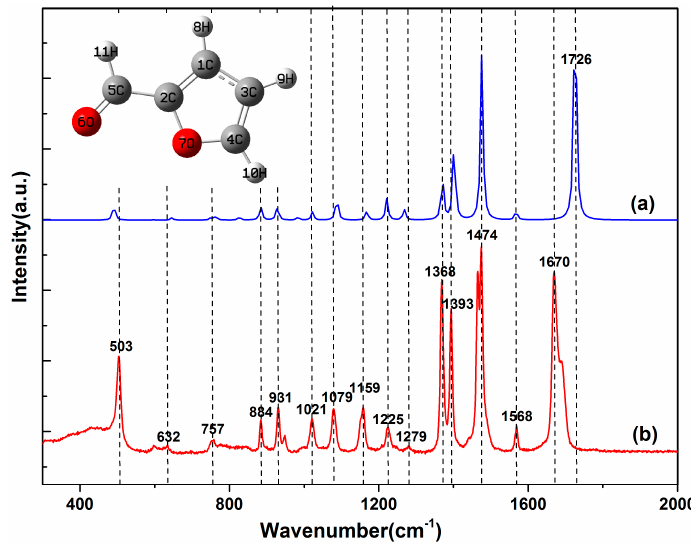
Figure 1. Raman spectra of pure furfural molecules: ( a ) Calculations and ( b ) Experimental measurements. The inset depicts the molecular structure of furfural molecule. Table 1. Raman vibration mode assignments of furfural